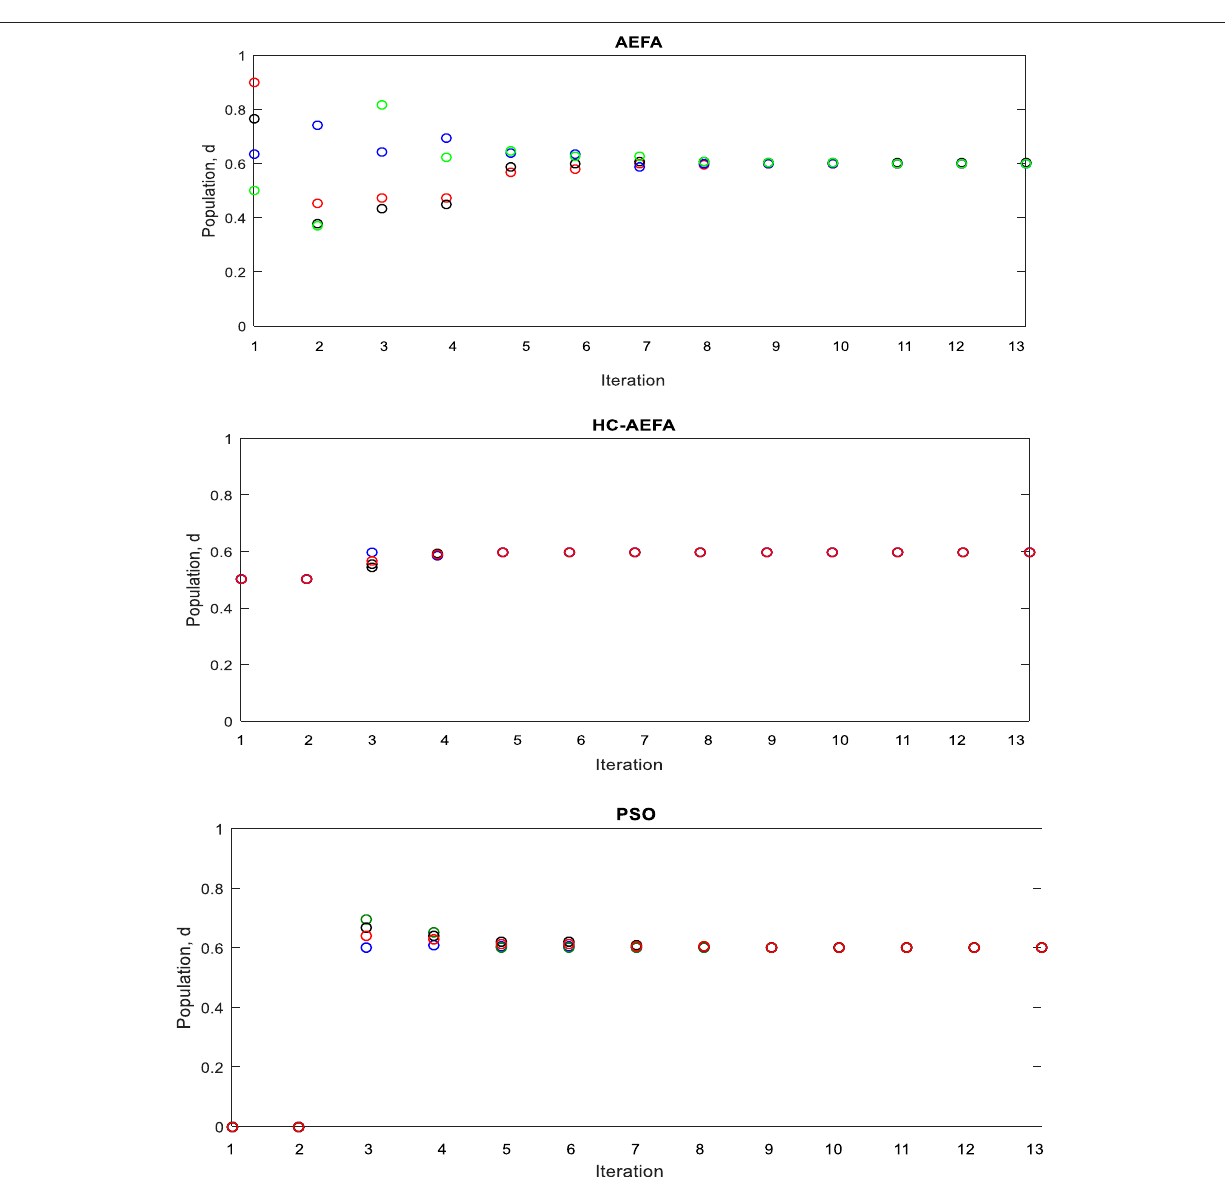
FIGURE 6 | Particles ’ positions in each iteration for the HC-AEFA, HC, AEFA, and PSO methods in the case of the fi rst pattern.